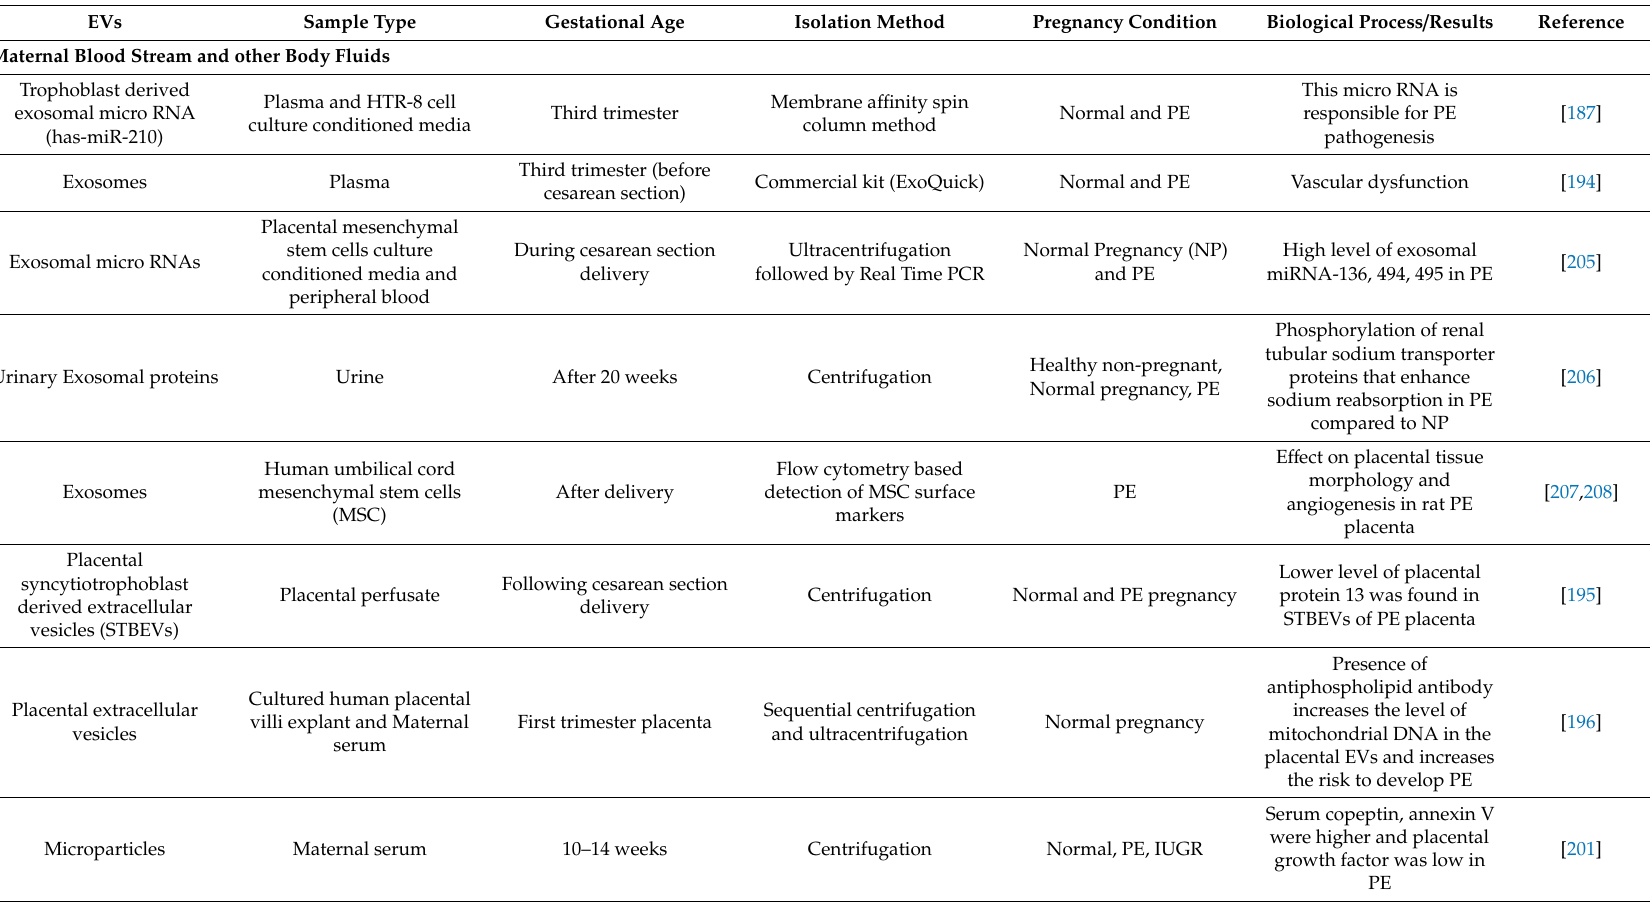
Table 2. Updated Research Studies on EVs in PE